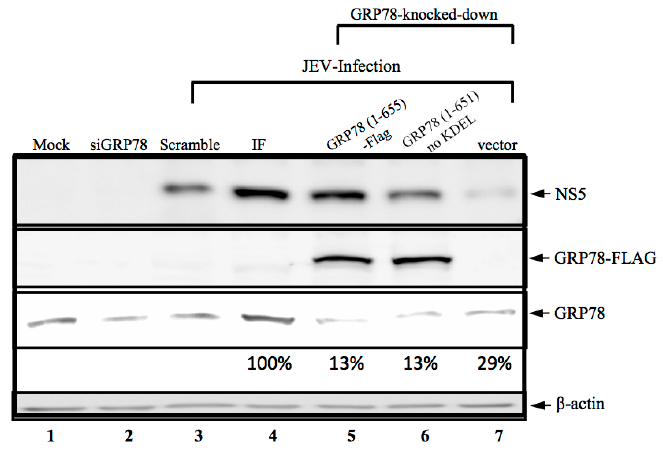
Figure 2. Ectopic expression of GRP78-Flag protein restores the JE viral protein production in the shGRP78 knocked down cells. BHK-21 cells were transfected with an antiGRP78 siRNA (Lane 2), scrambled siRNA (Lane 3) or infected with lentiviral vector containing the shGRP78-specific gene for generating GRP78 stable knocked down cells. The GRP78 knocked down cells were then overexpressed for full-length or KDEL-truncated GRP78 using transfected plasmids described in the Materials and Methods. Followed by infection with JEV, the cells were then harvested for the detection of viral nonstructural NS5 protein, GRP78-Flag tagged proteins, endogenous GRP78 and β -actin using the specific antibodies as indicated at the right. For the expression levels of GPR78 in wild-type and GRP78 stable knocked down cells, the quantitation of values of each lane are shown below the lane in the blot. Lanes assignments: Lane 1, BHK-21 cells used for negative control; Lane 2, the siGRP78 transfected cells; Lane 3, the scrambles siRNA transfected BHK-21 cells and infection with JEV; Lane 4, BHK-21 cells infected with JEV; Lane 5, the ectopically-expressed GRP78 protein (GRP78 (1-655)-Flag) and infection with JEV in the GRP78 knocked down cells; Lane 6, the ectopically-expressed KDEL-truncated GRP78 protein (GRP78 (1-651)-Flag) and infection with JEV in the GRP78 knocked down cells; Lane 7, the ectopically expressed Flag and infection with JEV in the GRP78 knocked down cells.